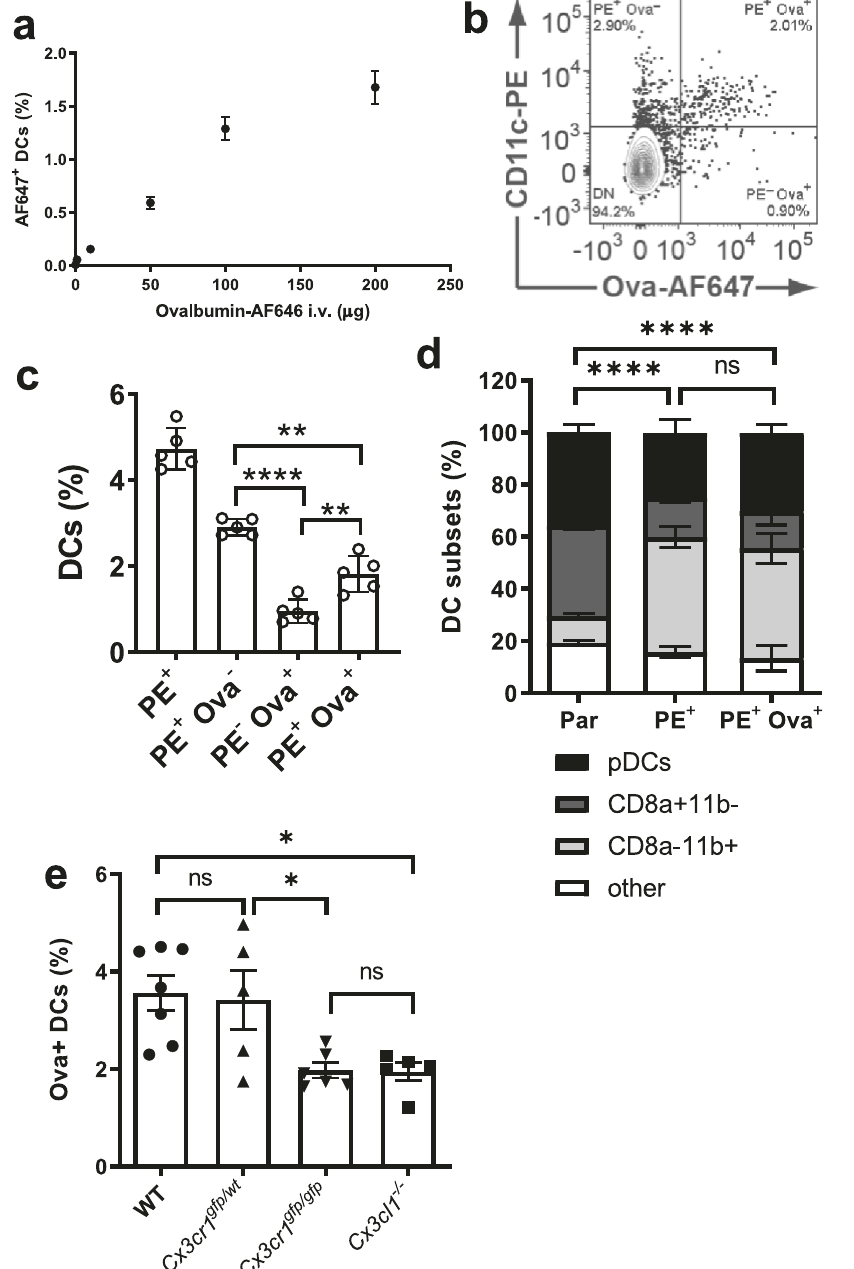
Fig. 7 Transendothelial thymic DCs capture blood-borne proteins. a Uptake of Alexa 647-labeled ovalbumin (Ova-AF647) by thymic DCs. Different doses of Ova-AF647 were injected IV and thymic DCs were harvested 5 min later. n = 3 experiments with three mice/group for 0 and 1 μ g, four mouse/ group for 10, 50 100, and 200 μ g. b Representative FACS plot of thymic DCs. In all, 5 min after IV co-injection of anti-CD11c-PE and 100 μ g Ova-AF647, thymic single-cell suspensions were obtained and stained for CD11c + DC. OVA-AF647 geometric mean fl uorescence intensity (geoMFI) for PE + subset (TE-DC) = 982 and for PE neg subset (Par-DC) = 75.1 (a.u.). c Frequency of thymic DCs that bound IV injected anti-CD11c-PE (PE + ) and/or Ova-AF647. n = 2 independent experiments with fi ve mice/group each, of which one representative experiment is shown (one-way ANOVA). d Subset analysis of thymic Par-DC (i.e., PE neg ), PE + DC (i.e., TE-DC) that did or did not acquire Ova-AF647. n = 2 independent experiments with 10 mice/group (two-way ANOVA). e Age and sex-matched wildtype (WT), Cx3cr1 gfp/ + , Cx3cr1 gfp/gfp , and Cx3cl1 – / – mice were injected with 100 µ g Ova-AF647 and thymi were harvested 5 min later for FACS analysis of DCs. n = 2 experiments with fi ve mice per group (one-way ANOVA). Bars and error bars represent mean ± SEM. c **** P < 0.0001; ** P = 0.0011 (PE + Ova − vs. PE + Ova + ) and P = 0.0073 (PE − Ova + vs. PE + Ova + ). d **** P < 0.0001. e * P = 0.0217 (WT vs. Cx3cl1 − / − ) and P = 0.0172 (WT vs. Cx3cr1 gfp/gfp ), DCs dendritic cells, pDCs plasmacytoid dendritic cells.